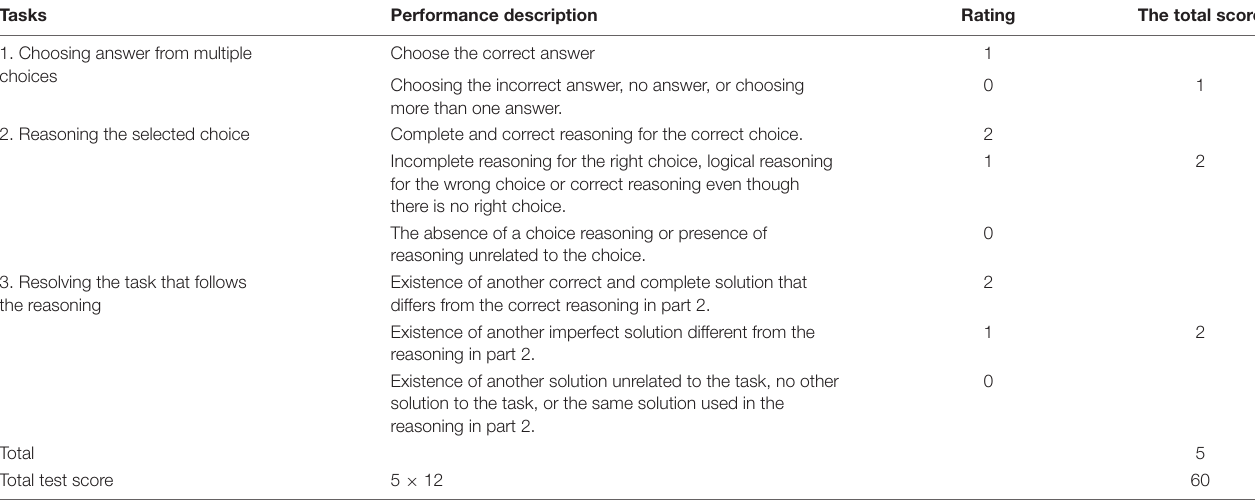
TABLE 2 | Rubric of proportional reasoning test scoring. Tasks Performance description